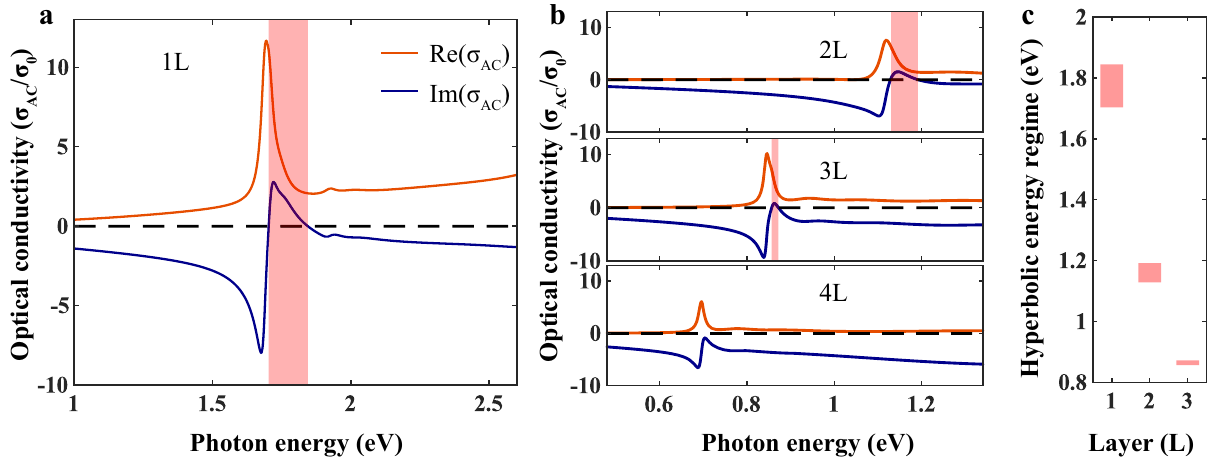
Fig. 4 Thickness-dependent HEPs in atomically thin BP. Extracted optical conductivity of atomically thin BP ( a ) 1 L ( b ) 2L-4L. The hyperbolic regime is marked by the pink area. When the layer number increases, the area becomes narrower, and the onset shifts from the visible to the near-infrared range. c hyperbolic regime as a function of layer